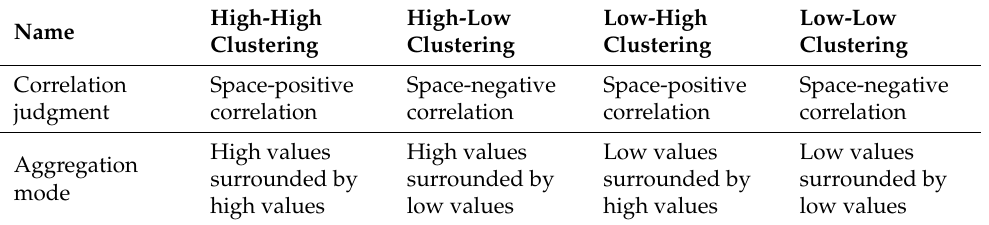
Table 1. Local autocorrelation cluster